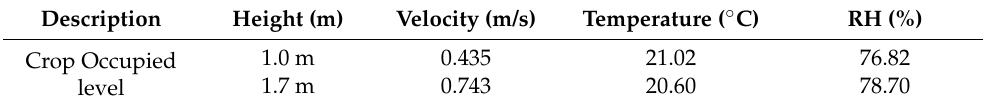
Table 5. Summary of area weighted average crop growth parameter values from CFD